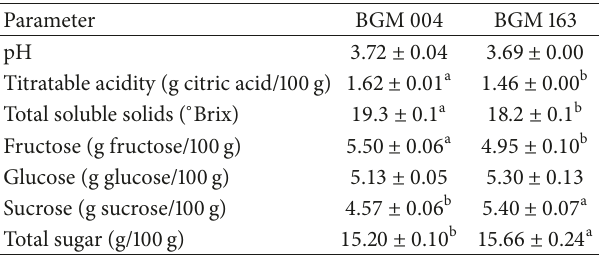
Table 2: Sugars contents, titratable acidity, pH, and soluble solids determination in the pulp of sweet passion fruit